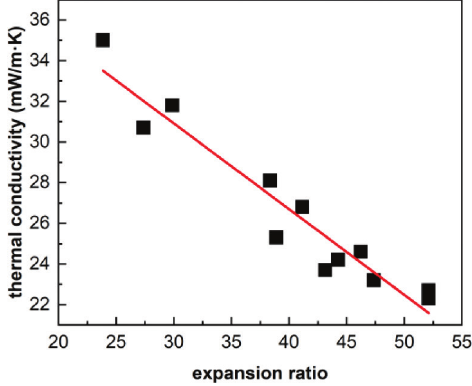
Figure 2: Relationship between the thermal conductivity and expansion ratio of the of PS-MCF materials.